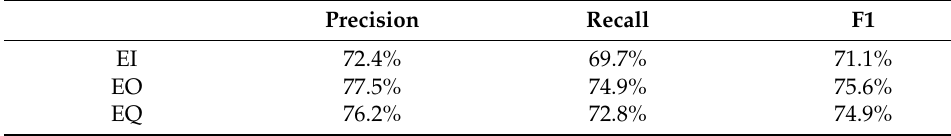
Table 11. Results of FP attribution classification.